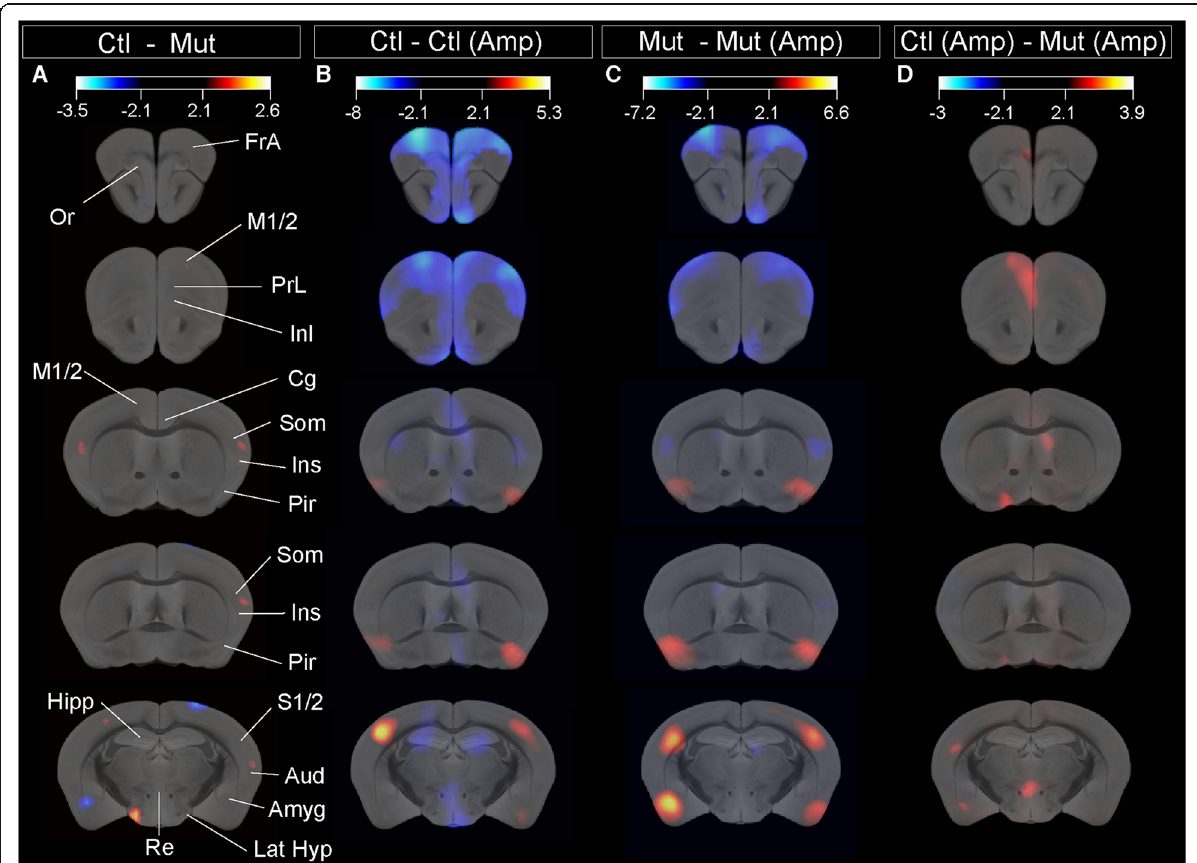
Fig. 1 [ 18 F]-FDG PET scanning in control and D2 mutant animals under basal conditions or after the induction of a hyperdopaminergic state. Subtractive analysis of [ 18 F]-FDG incorporation in the following: a control and mutant animals in basal conditions. b Control animals in basal condition and control animals in amphetamine-treated condition. c Mutant animals in basal condition and amphetamine-treated condition. d Control and mutant animals in amphetamine-treated conditions. [ 18 F]-FDG incorporation is depicted in red-yellow color for metabolic activity increase in control animals ( a ), animals in basal conditions ( b , c ), or control animal after amphetamine treatment ( d ) or blue-white color for metabolic activity increase in mutant animals in basal condition ( a ) or animals after amphetamine treatment ( b – d ). t values for p < 0.05 are specified for each comparison. FrA frontal association cortex, M1/2 primary/secondary motor cortex, Or orbital cortex, PrL prelimbic cortex, InL infralimbic cortex, Cg cingulate cortex, Som somatosensory cortex, Ins insular cortex, Pir piriform cortex, Aud auditory cortex, Hipp hippocampus, Amyg amygdala, Re reuniens nucleus, Lat Hyp lateral